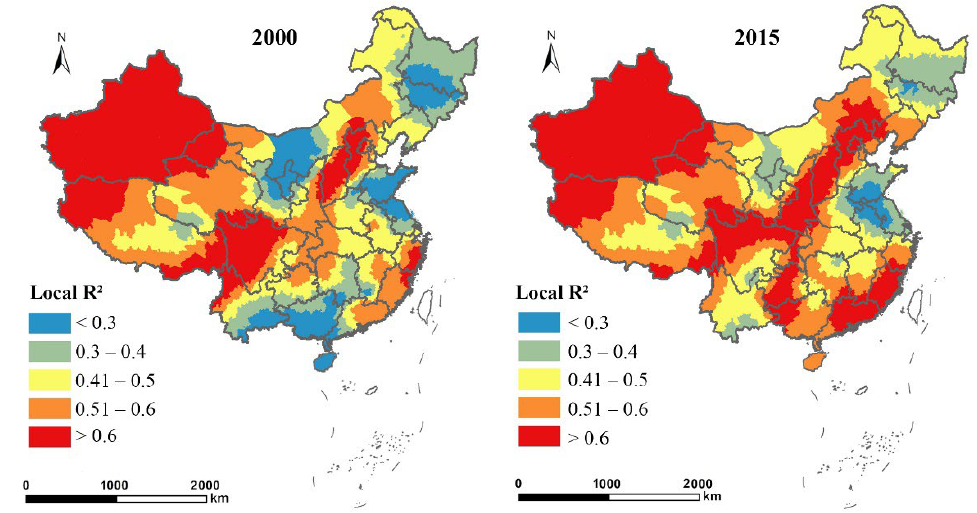
Figure 5. Spatial distribution of local R 2 in the GWR model with urban economic density (ln ED ) as the dependent variable in 2000 and 2015.